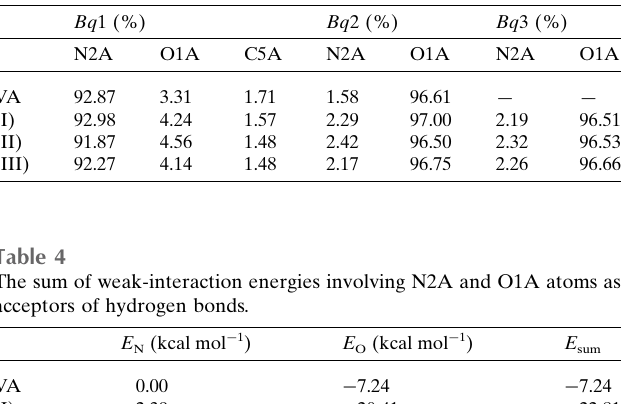
Table 3 Source-function contributions to VSCC maxima showing the change in electron density.